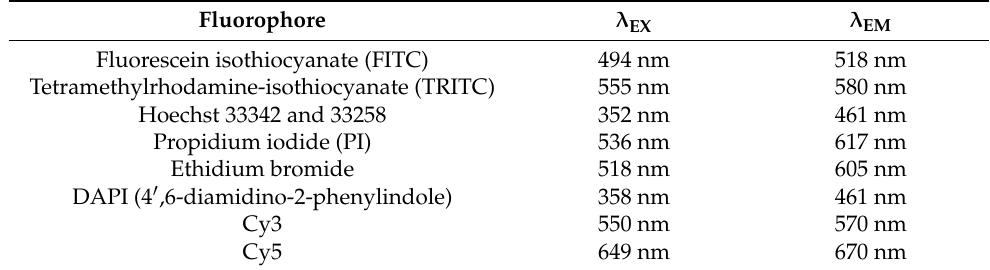
Table 5. Overview of important fluorophores and their excitation ( λ EX ) and emission ( λ EM )